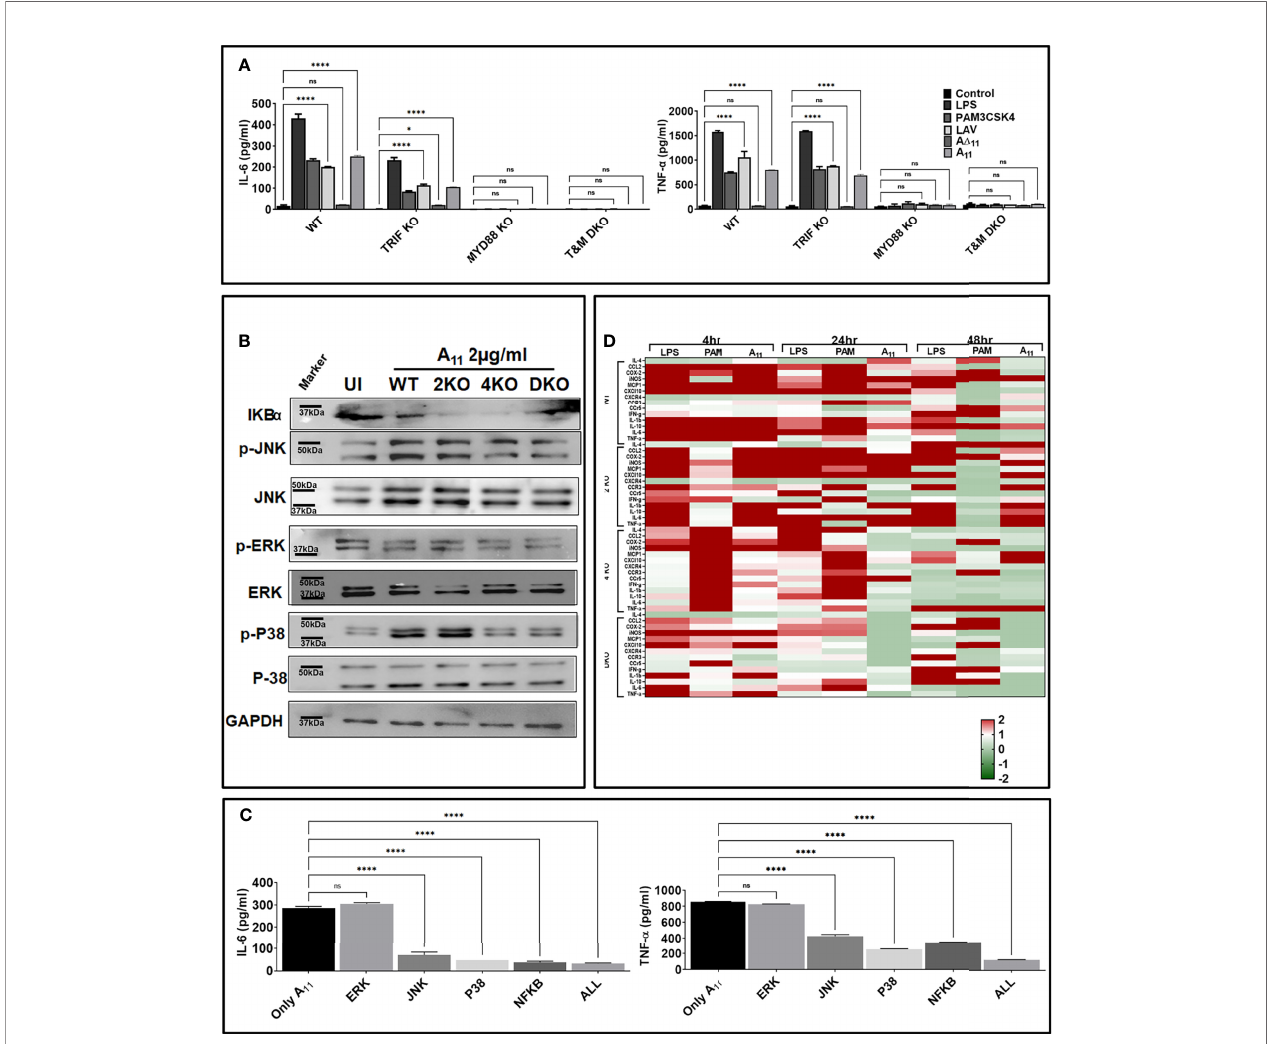
FIGURE 3 | 11 th domain of LigA (A 11 ) produces pro-in fl ammatory cytokines via signalling through MAP kinase involving p38 and JNK pathway. (A) A 11 signals through TLR4 involving the MyD88 adapter. WT, MyD88 KO, TRIF KO and TMDKO bone marrow-derived macrophages cell lines were treated with LAV or A 11 or A Δ 11 (2 m g/ml) for 24h at 37°C in the presence of 5%CO 2 and levels of IL-6 and TNF- a in the supernatants were measured by ELISA. (B) A 11 signals through TLR4 via the MAP kinase pathway involving p38 and NFkb. WT or TLR2KO or TLR4KO or DKO macrophages cell lines were stimulated with A 11 (2 m g/ml) for 24h at 37°C in the presence of 5%CO 2 . Levels of phosphorylated p38, JNK, and ERK1/2 induced by A 11 were analyzed by western blot as described in materials and methods. (C) Pharmacological inhibitors of p38 and NFkb signi fi cantly reduces A 11 mediated cytokine response . RAW 264.7 cells were pre-treated for 30min with NF-kB inhibitor (SN50; 20 m M), JNK inhibitor (SP600125; 40 m M) or p38MAPK inhibitor (SB203580; 30 m M) or ERK (U0126; 50µM) or all four inhibitors together and then stimulated with A 11 (2 m g/ml) for 24h at 37°C in the presence of 5%CO 2 and supernatant was collected to measure levels of IL-6 and TNF- a by ELISA. (D) Analysis of expression of immune response-related genes in mouse macrophages stimulated with A 11 . WT, TLR2KO, TLR4KO and DKO mouse macrophage cell lines were treated with 2 m g/ml A 11 for 4h or 24h or 48h. Cells were recovered, RNA was isolated, converted to cDNA and gene expression was analyzed by RT-PCR as described in material and methods. The data were presented as fold changes between stimulated cells vs control and normalized to GAPDH. E . coli LPS (500ng/ml) or PAM3CSK4 (20ng/ml) as TLR4 and TLR2 ligands respectively were used as positive controls in all experiments wherever indicated. All data are representative of three independent experiments. Signi fi cant differences were calculated using the one or two way ANOVA (****, *, ns indicates P < 0.0001, P < 0.05 and non- signi fi cant